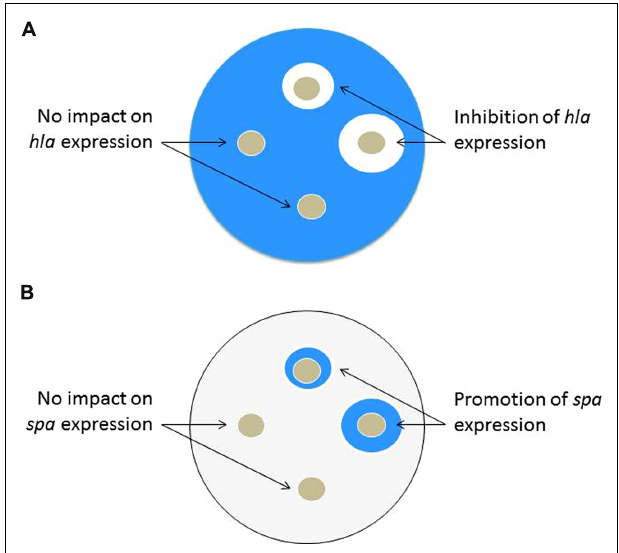
FIGURE 3 | Schematic representation of the X-GAL agar plate test, which can be used in QSI screening efforts of either individual compounds or more complex natural product extracts. QSIs are identified by presence of both a white ring in the hla::lacZ plate and blue ring on the spa::lacZ plate. (A) hla::lacZ plate: following incubation of the plate containing the hla reporter, a white clearing surrounding the hole punch containing the QSI candidate indicates reduced expression of hla ( α -toxin). (B) spa::lacZ plate: following incubation of the plate containing the spa reporter, a blue zone surrounding the hole punch containing the QSI candidate indicates increased expression of spa (Protein A).